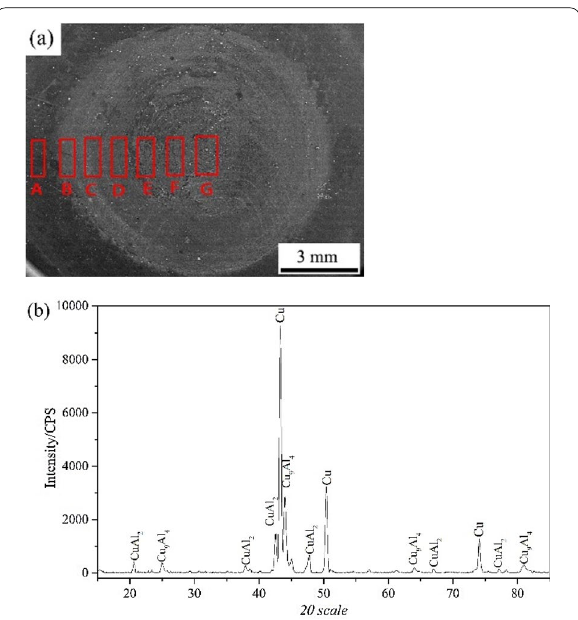
Figure 11 ( a ) Interfacial fractured surface on the cupper side of the weld fabricated using a sleeve penetration depth of 1.8 mm, ( b )